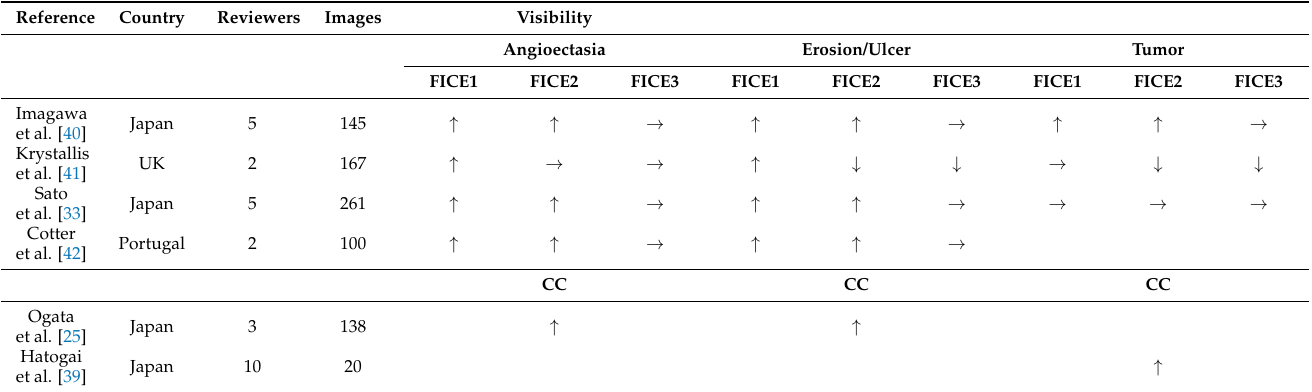
Table 2. Clinical studies involving image-enhanced capsule endoscopy for the visibility of small intestinal lesions. Reference